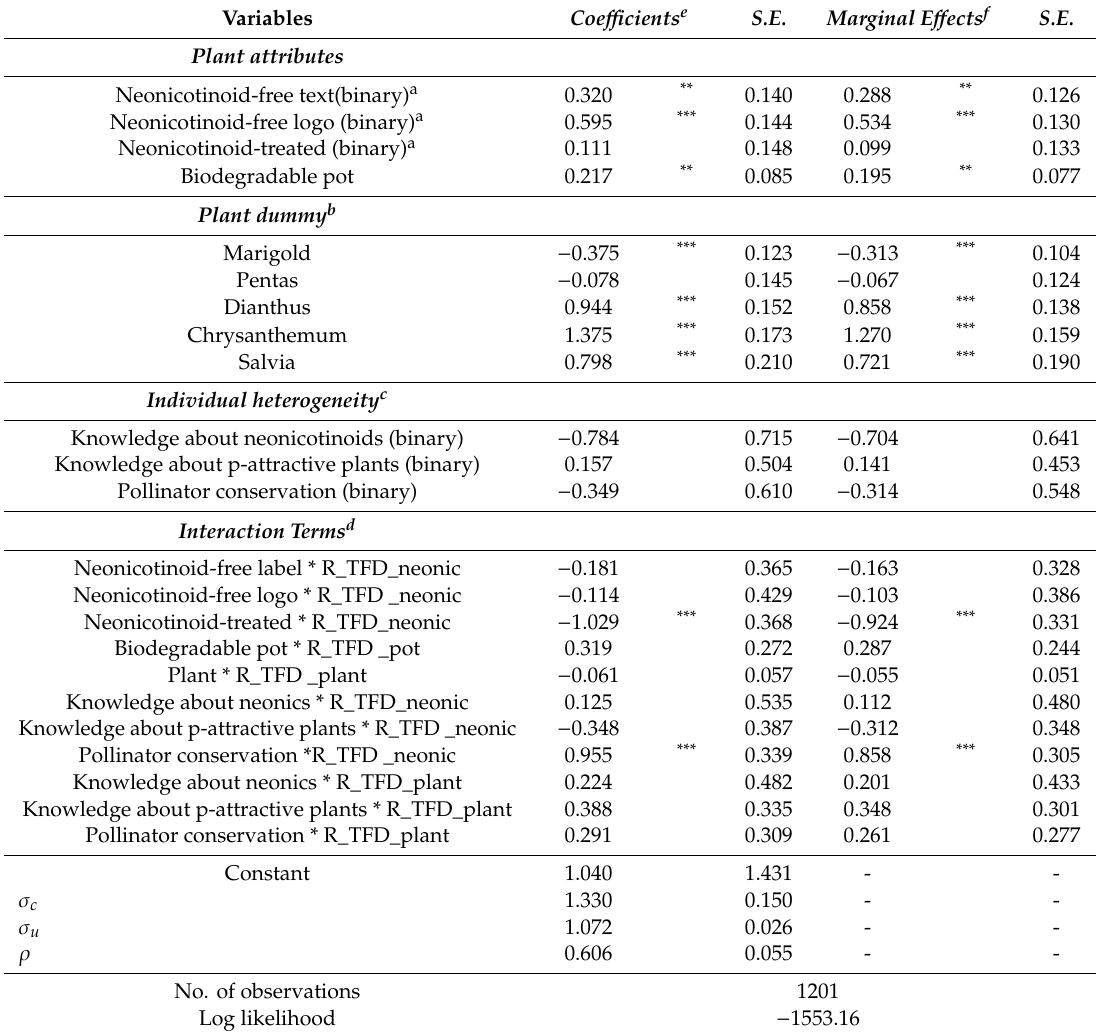
Table A4. E ff ects of attribute focus (measured by relative total fixation duration) on bid value: random e ff ects tobit